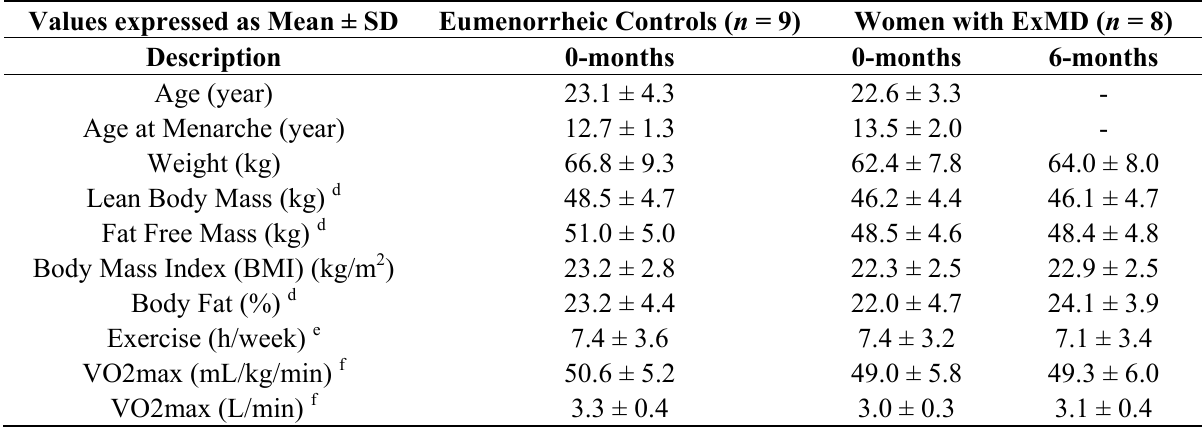
Table 1. Physical characteristics in athletes classified as eumenorrheic (Eumen) or with exercise-induced menstrual dysfunction (ExMD) before and after a 6-month dietary intervention a–c .